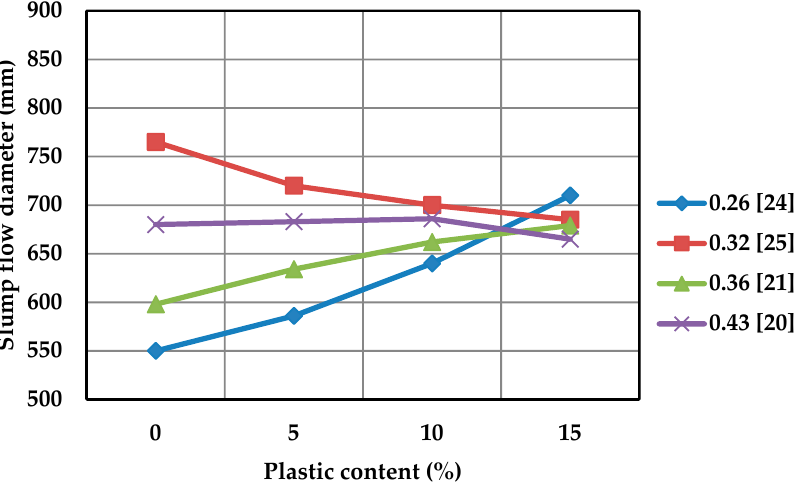
Figure 3. Slump flow variations with different plastic replacements for sand. 202